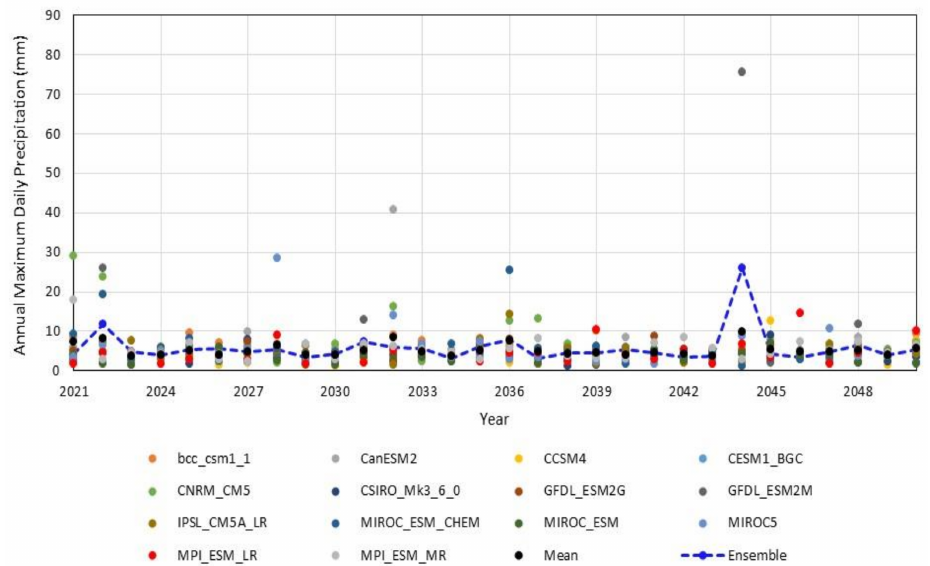
Figure 14. Annual maximum daily precipitation projected by 14 climate models under the RCP8.5 scenario for the Devil’s Creek. The dashed blue line corresponds to the ensemble. Period: